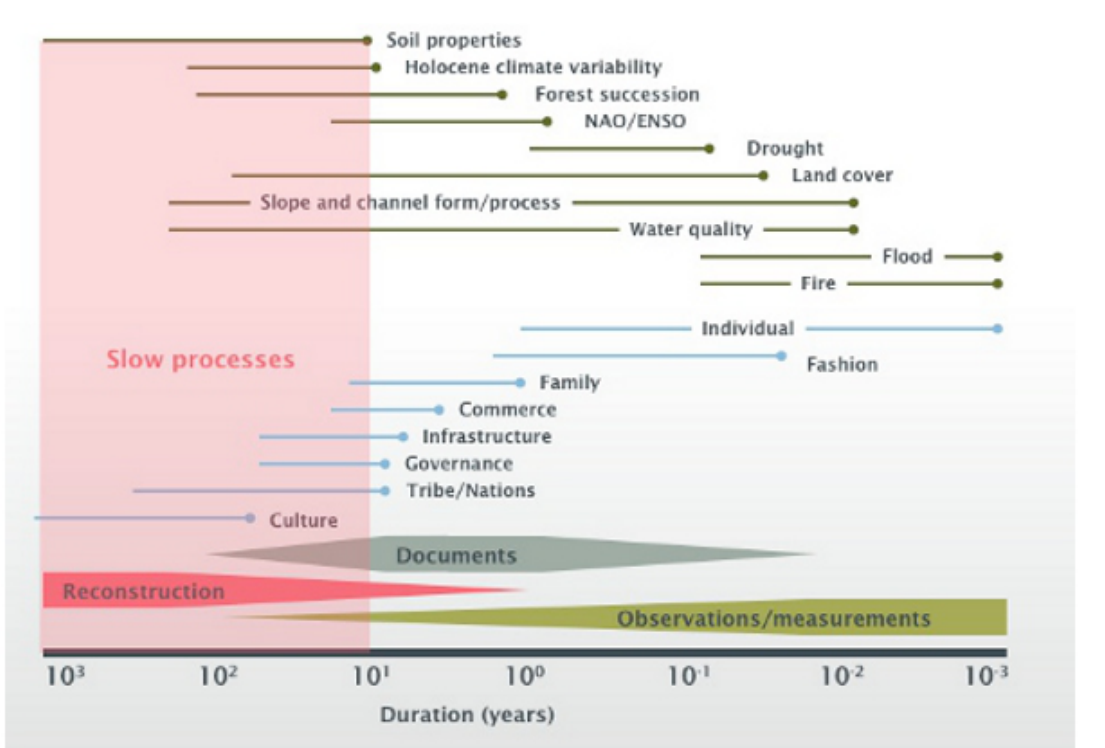
Fig. 1. Slow and fast